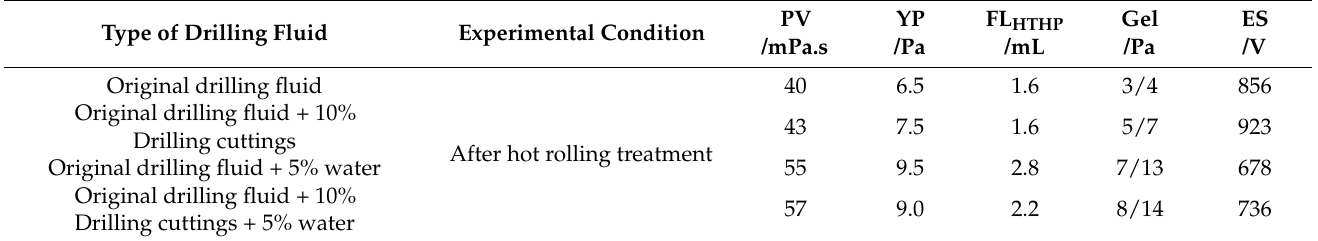
Table 4. Test results of oil-based drilling fluid resistance to rock cuttings and water